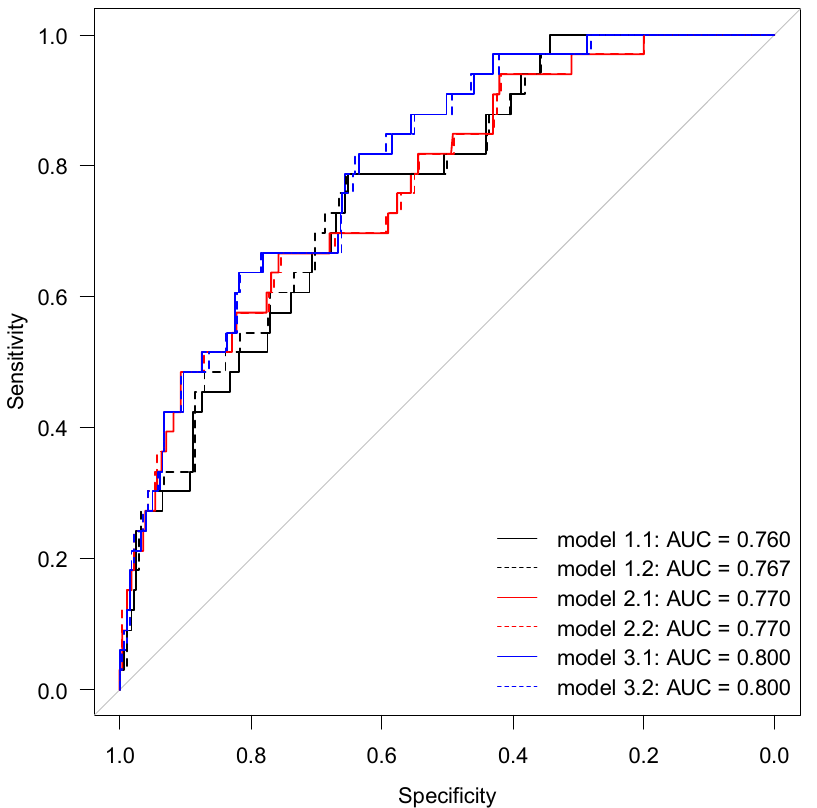
Figure A2. Receiver operating characteristic (ROC) curve for AKI prediction. Model 1.1 includes suPAR+CRP; model 1.2 includes model 1.1+IL6; model 2.1 includes NGAL+CRP; model 2.2 includes model 2.1+IL6; model 3.1 includes interaction between suPAR and NGAL (2-variable interaction) + CRP; and model 3.2 includes model 3.1+IL6.